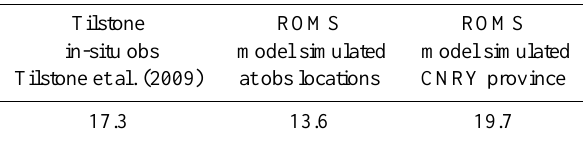
Comparison of simulated and in-situ estimates of